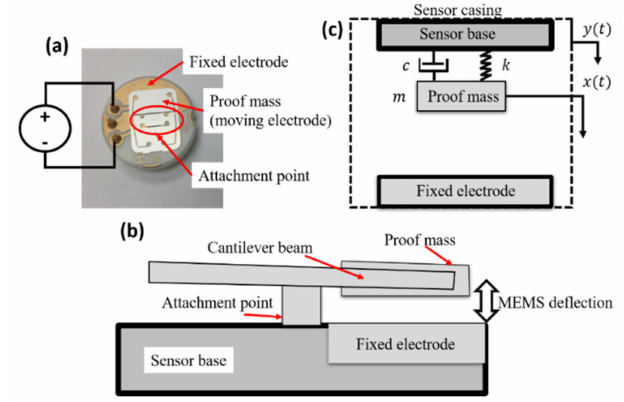
Figure 2. Microelectromechanical systems (MEMS) device schematics. ( a ) MEMS accelerometer used in this study. ( b ) Schematics of the MEMS side view showing the fixture the electrostatic gap. ( c ) Single-degree of freedom model of the MEMS accelerometer. Here, c = 2 ζ m ef f ( 2 π f n ) is the damping constant and k = ( 2 π f n ) 2 m ef f is the linear sti ff ness of the MEMS